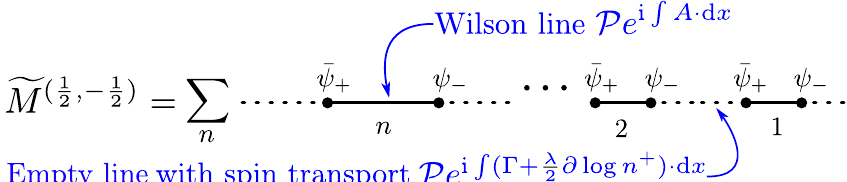
Figure 12 . The condensed fermionic line operator is defined perturbatively by integrating fundamen- tal and anti-fundamental fermions along the path, (4.6). Neighboring ordered pairs of fundamental and anti-fundamental are connected by Wilson lines. In between these pairs, we have a topological transport of the transverse spin with the connection (4.2). We call these segments “ empty ” because they do not have fields inserted on